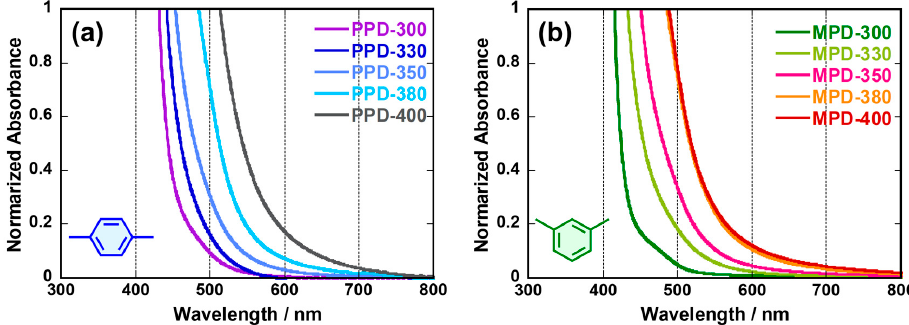
Figure 1. UV-Vis absorption spectra of PI films derived from ( a ) PPD and ( b ) MPD.